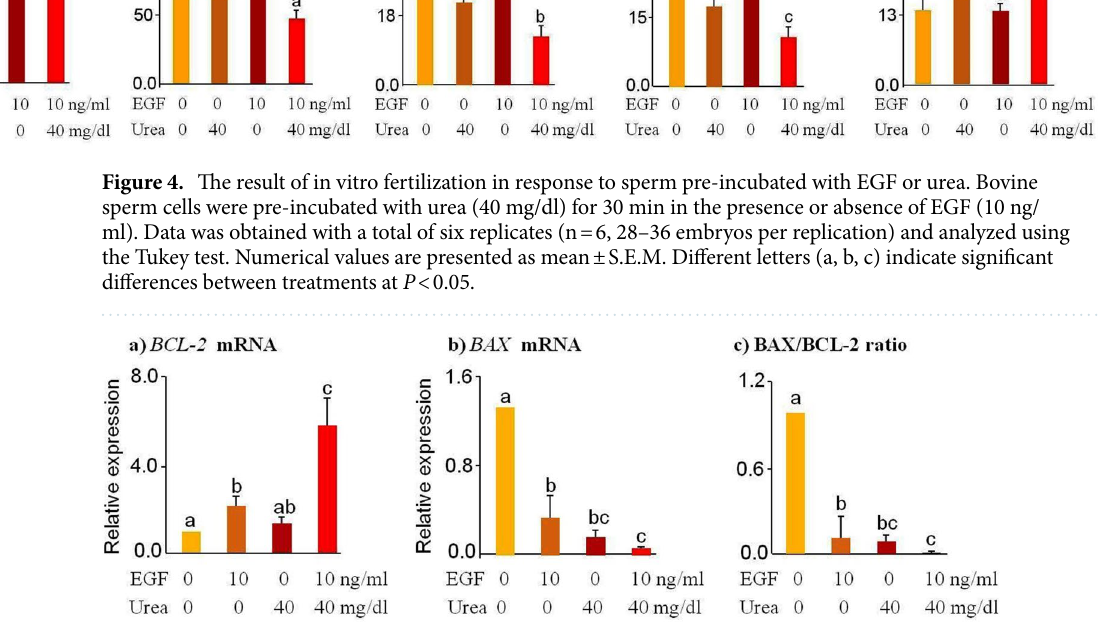
(Fig. 3b,c); however, sDF ( p < 0.05, Fig. 2e) and ROS levels (Fig. 3b,c) in EGF-urea-pretreated sperm cells were still higher than in the control group.